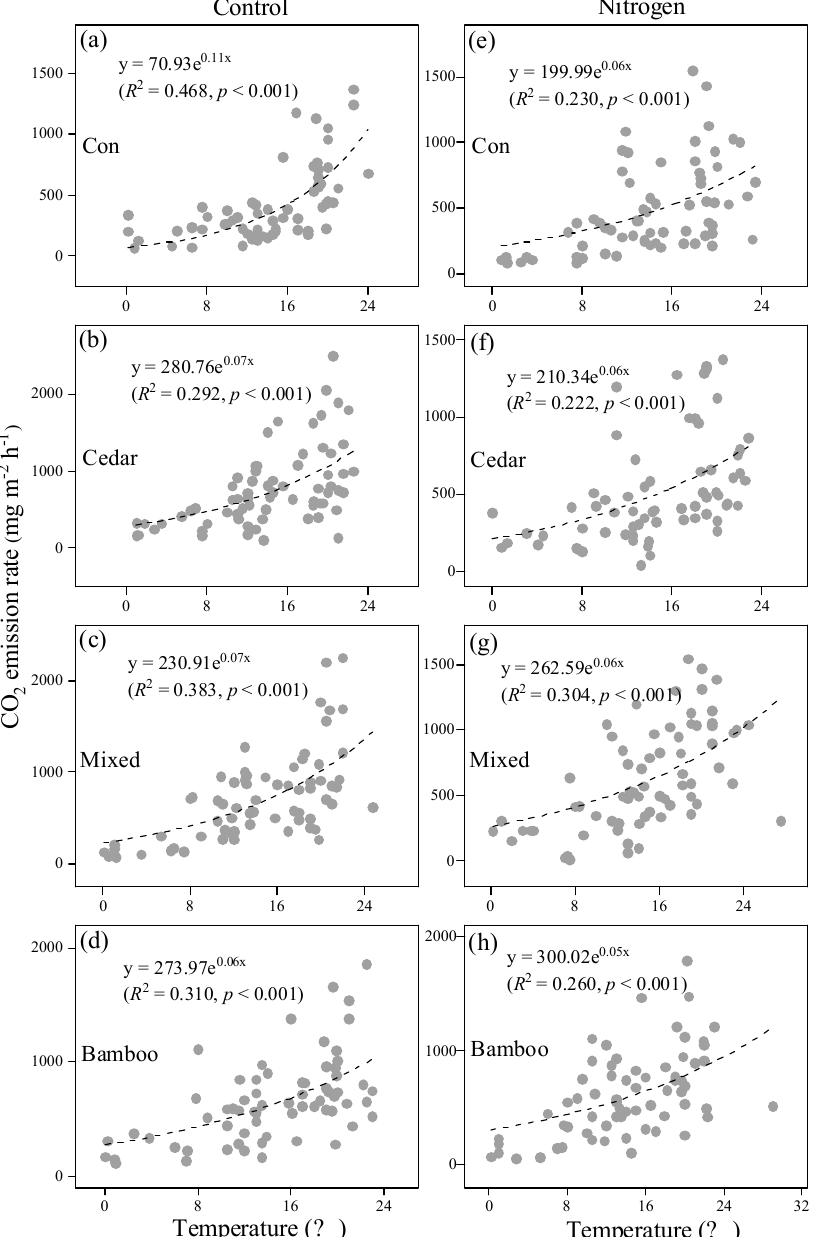
Figure 4. Correlations between soil CO 2 emission rate (mg m − 2 h − 1 ) and soil temperature (°C) with different nitrogen (control vs. nitrogen) and fine root litter (con, a and e; cedar fine root, b and f; mixed fine root litter, c and g; bamboo fine root, d and h) treatments. Goodness of fit of the data to the single positive exponential model ( R 2 ) and p values are shown.